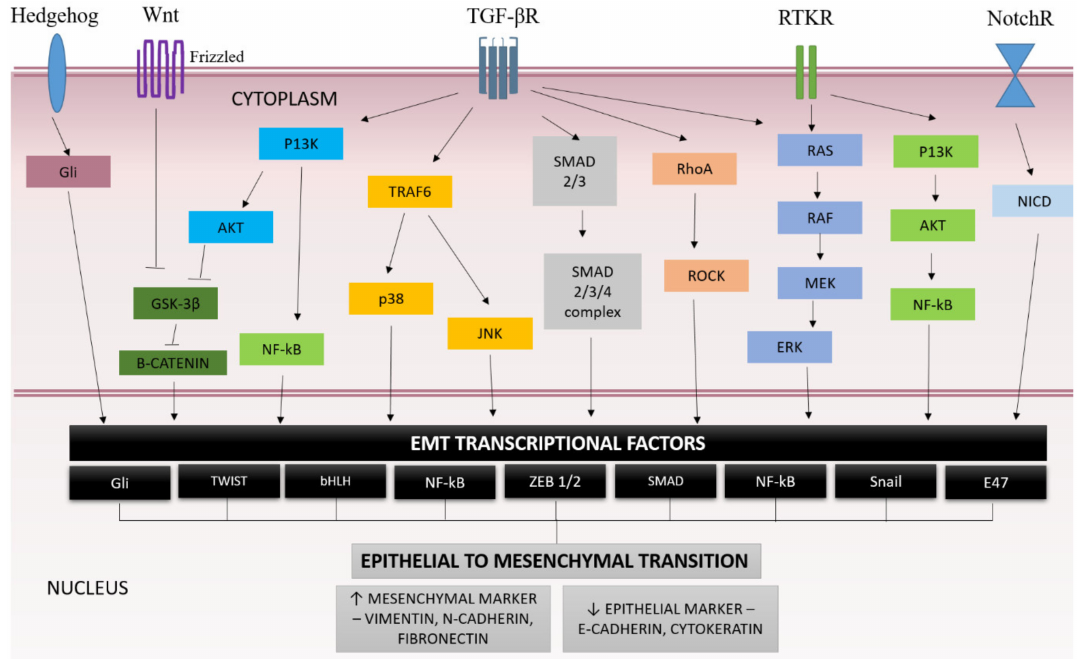
Figure 1. Signaling pathways regulating epithelial-mesenchymal transition (EMT) mechanisms